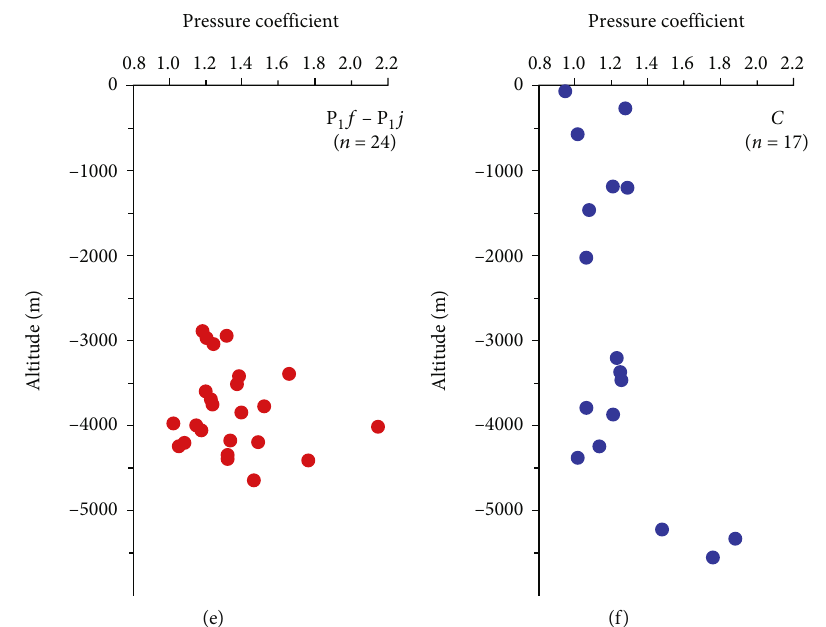
Figure 3: Relationship between measured pressure coe ffi cient and altitude in the Mahu sag.